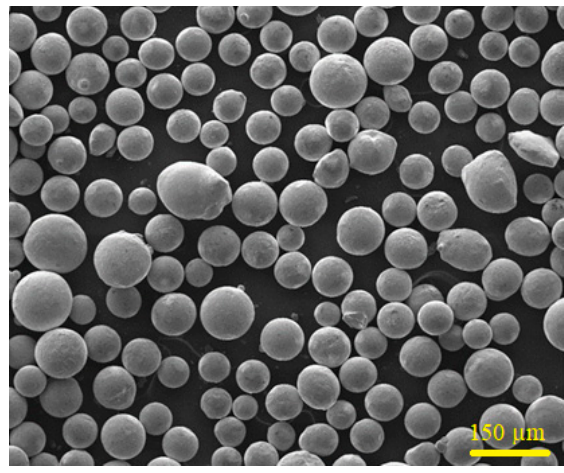
Figure 1. FESEM picture of as-received Colmonoy-6 particles.